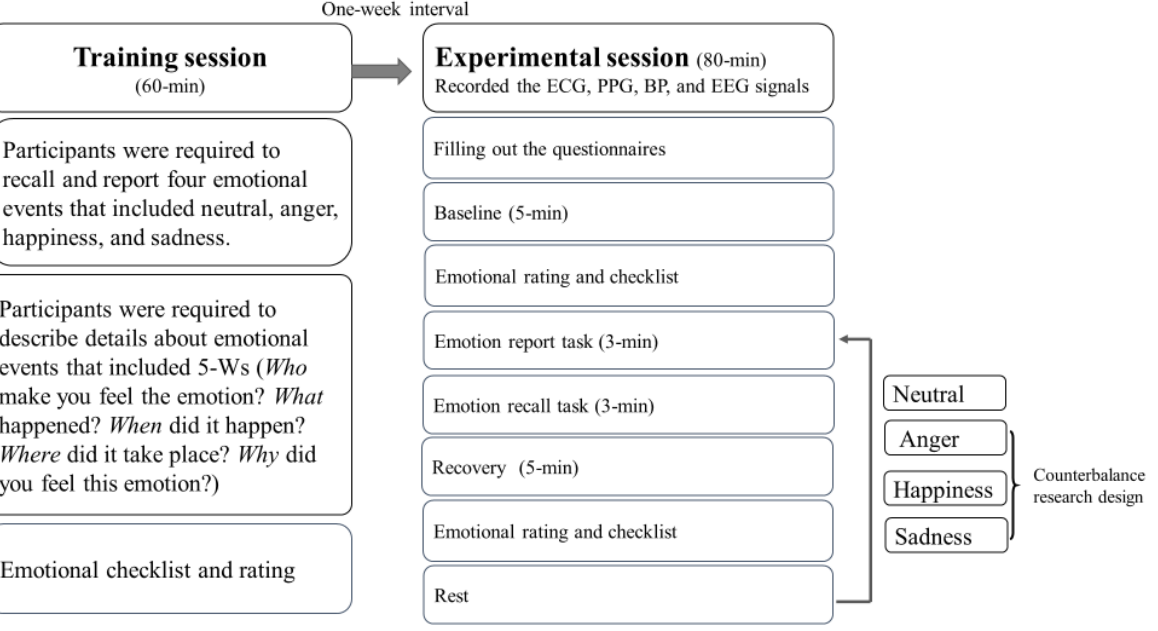
Figure 2. The procedure for the training and the experimental sessions, and the protocol for physi- ological signals